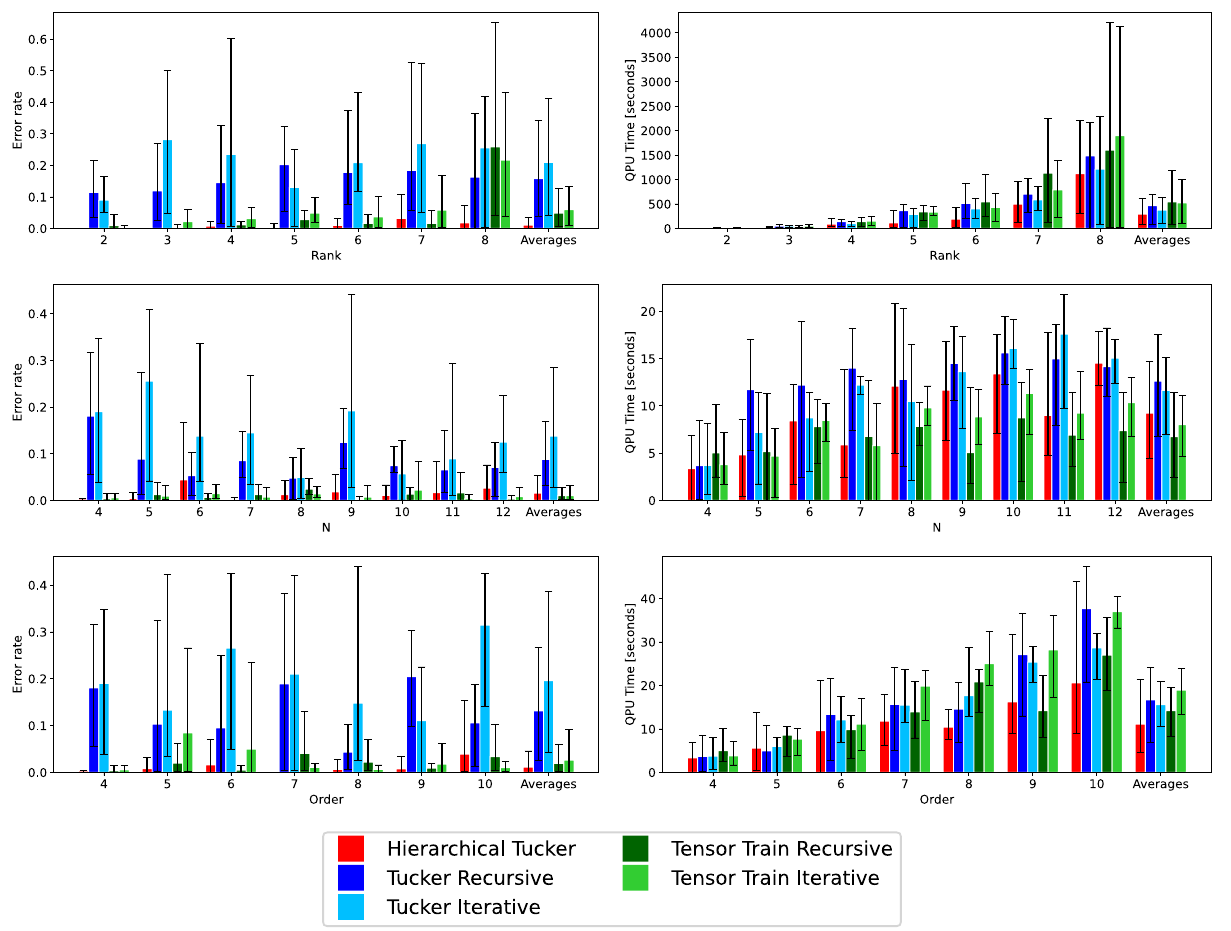
Figure 8. Tensors with noise. Mean error rate (left column) and mean QPU time (right column). Tensor rank (top row), dimension size N (middle row), and tensor order (bottom row). The right most entry on the x-axis shows the average across all previous quantities for each of the five tensor methods. Error bars indicate minimum and maximum